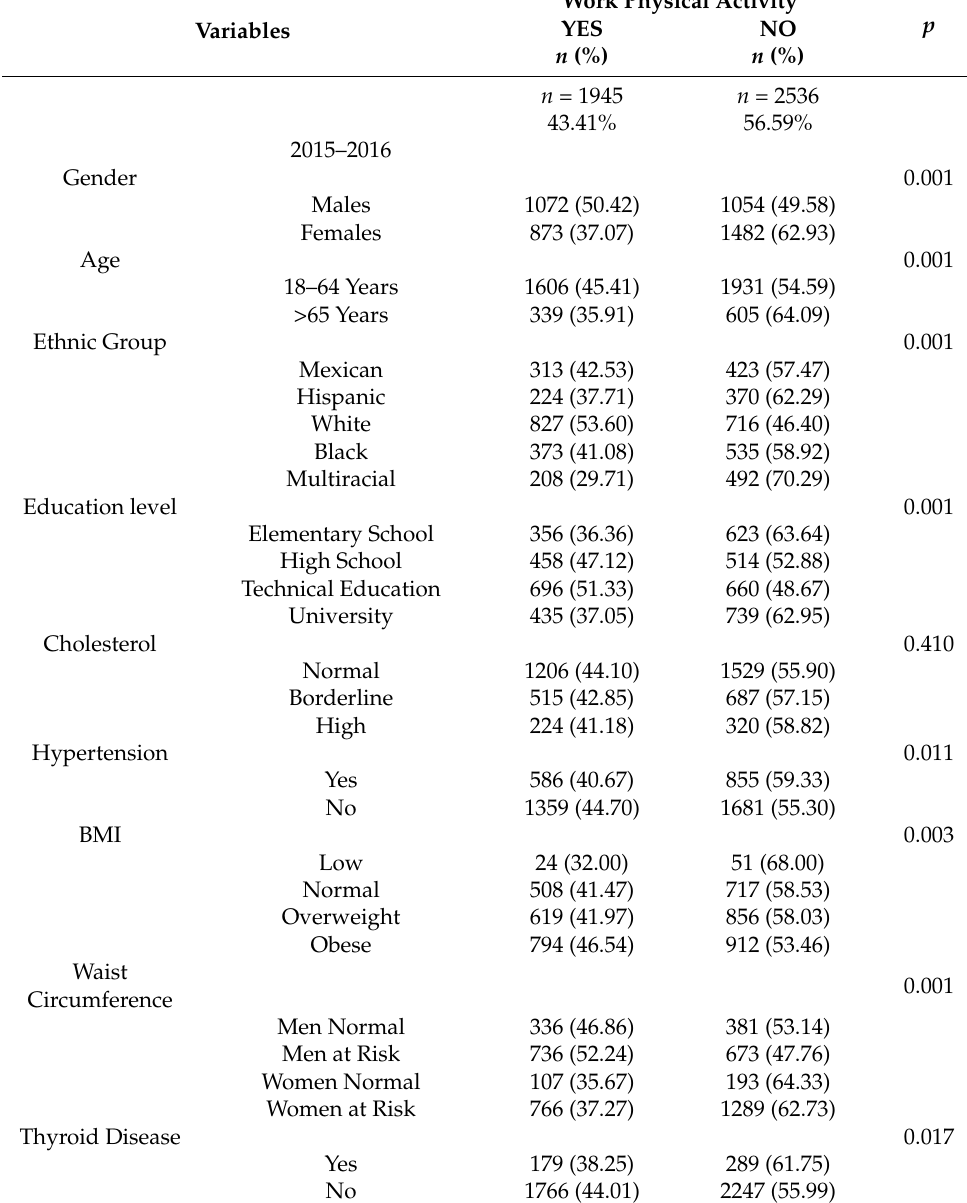
Table 1. Characteristics of work physical activity in U.S. adults from the NHANES